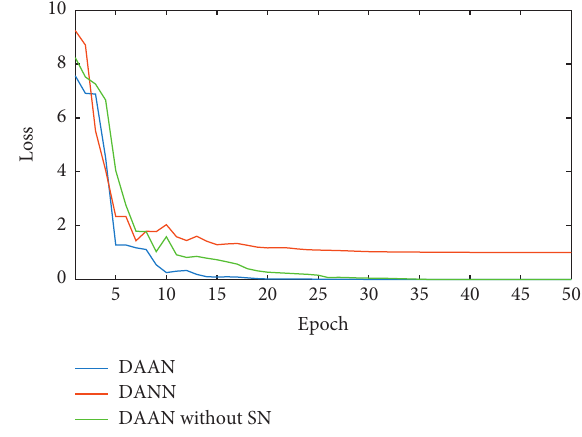
Figure 4: Comparison of training losses.